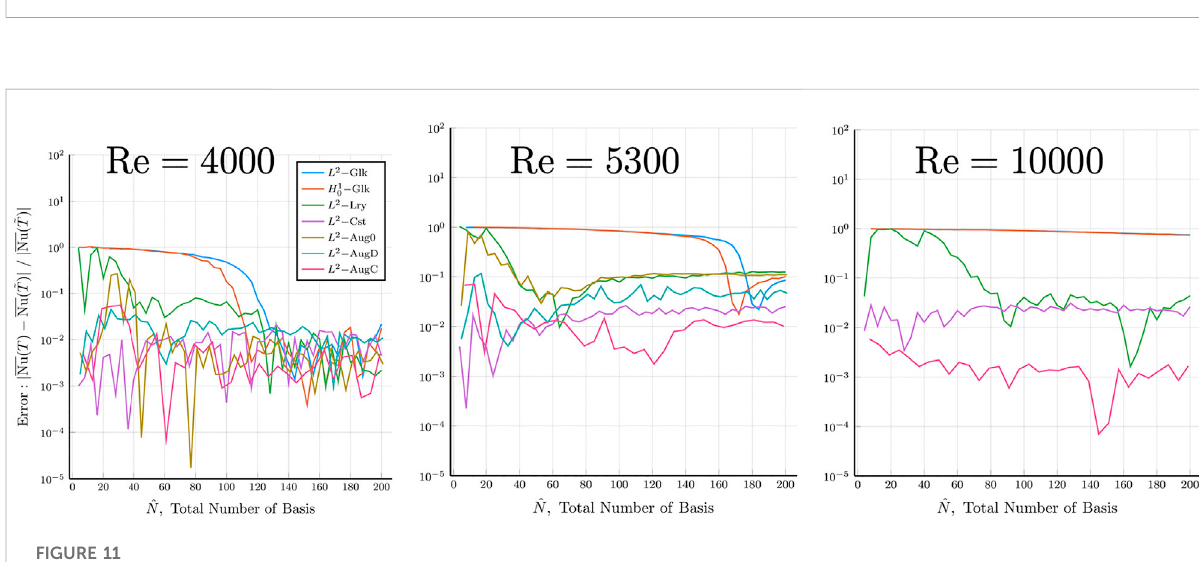
Pipe fl ow mean temperature error (top) and thermal variance results (bottom), for Re = 4,000, 5300, and 10,000 (FOM: τ = 50, ROM: τ = 500), curve broken by blowup solution.